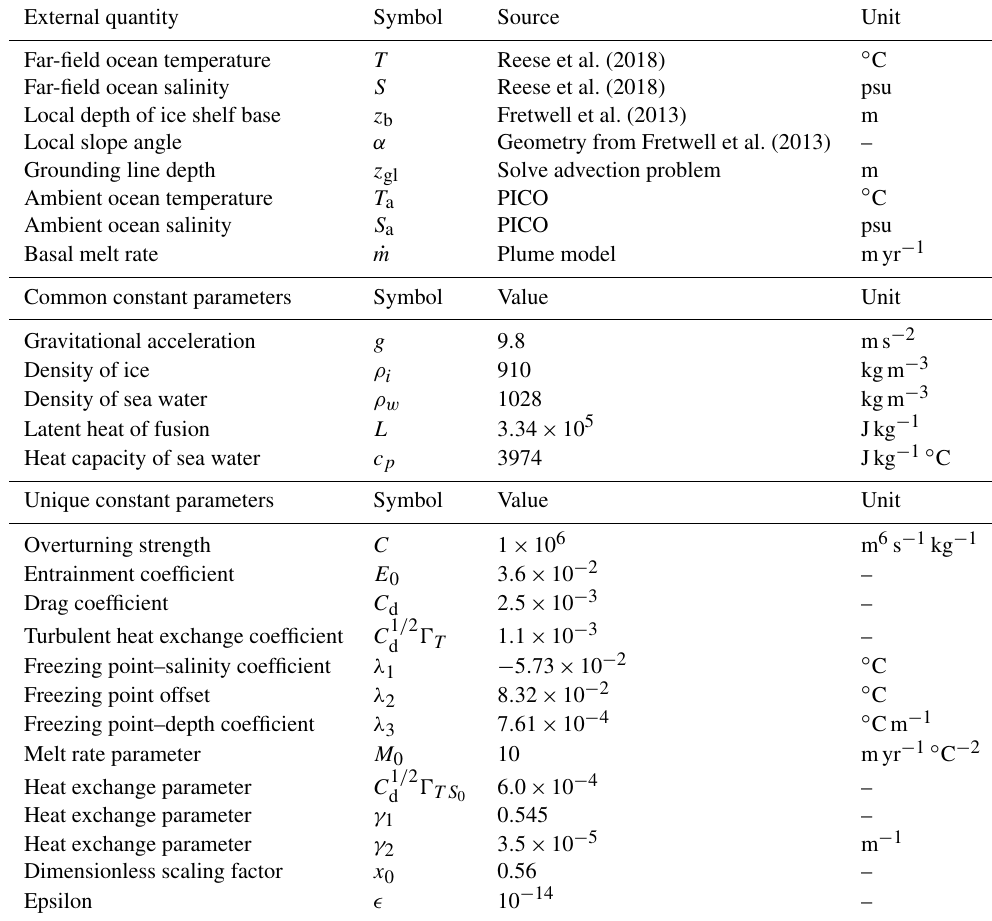
Table 1. Constant parameters and external quantities referenced in this communication. Common parameters are those used in the derivation of both PICO and the plume model. Unique parameters are from the derivation of the plume model, except for the overturning strength, which was taken from PICO. See Reese et al. (2018) and Lazeroms et al. (2018) for a full list of constants used to derive